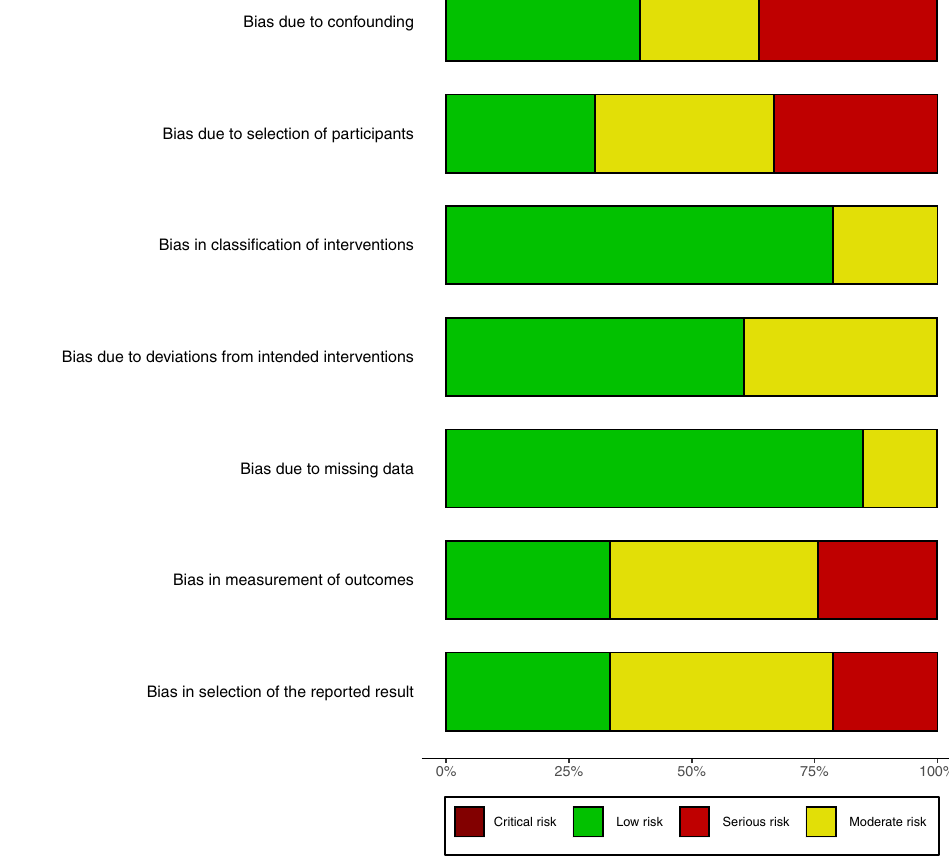
Fig. 4 Summary of the risk of bias assessment for non-randomized studies. The bars show the percentage of studies with different levels of quality as indicated by